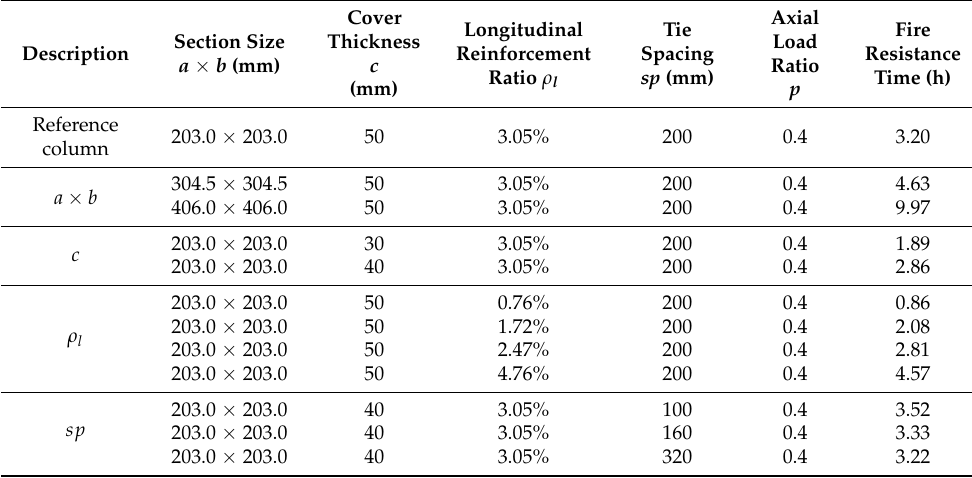
Table 4. Column characteristic and fire resistance